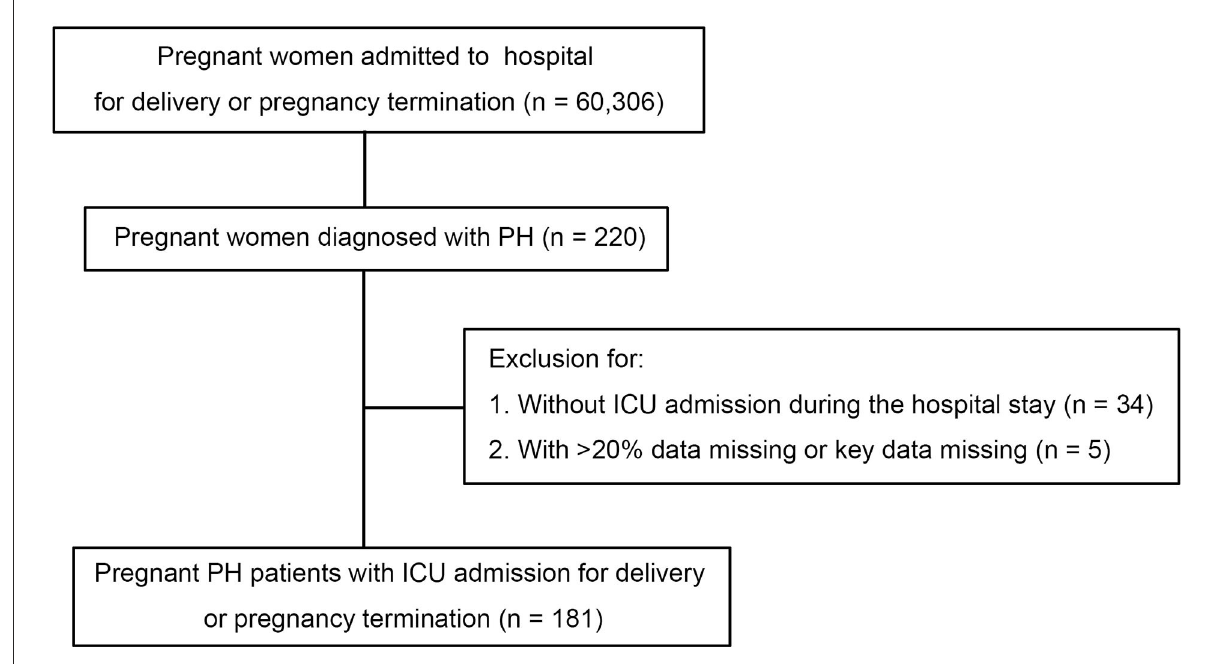
FIGURE1 Study population and process of inclusion. ICU, intensive care unit; PH, pulmonary